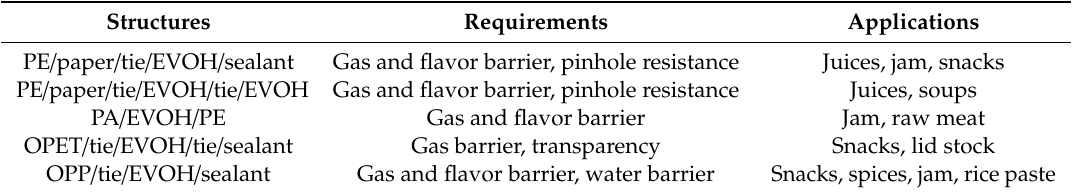
Table 1. Packaging based on ethyl vinyl alcohol (EVOH) for food applications (adapted) [76].